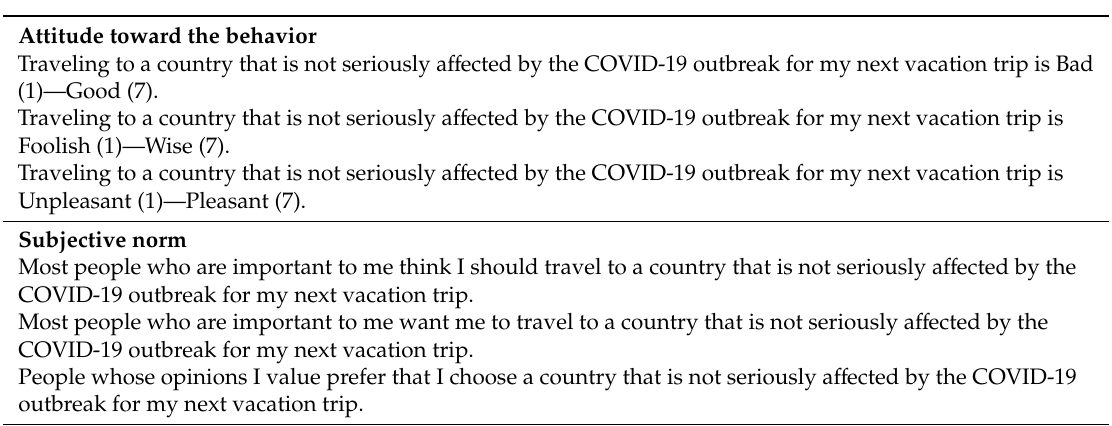
Table A1. Measurement items for research